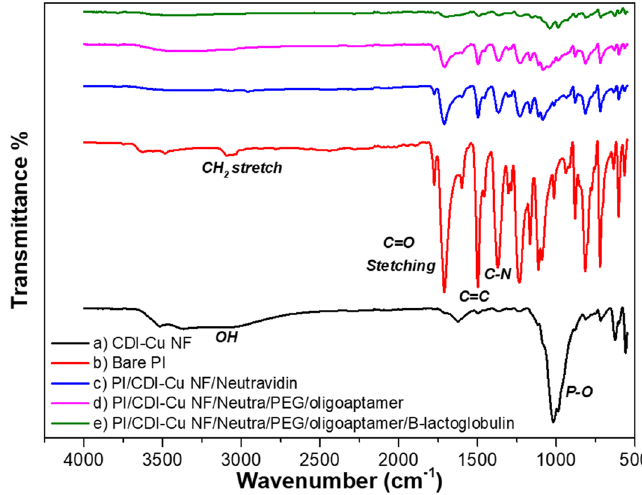
Figure 4. FTIR analysis of different modifications with PI film, ( a ) CDI-Cu NF; ( b ) bare PI film; ( c ) neutravidin/CDI-Cu NF; ( d ) oligoaptamer/neutravidin/CDI-Cu NF; ( e ) β-lactoglobulin/oligoaptamer/ neutravidin/CDI-Cu